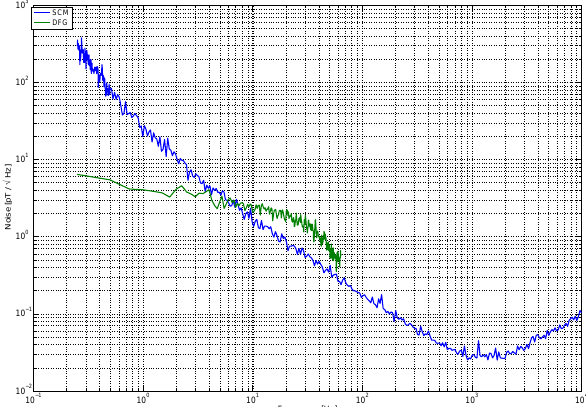
Figure 1. Comparison of search coil (SCM) and fluxgate (DFG) noise